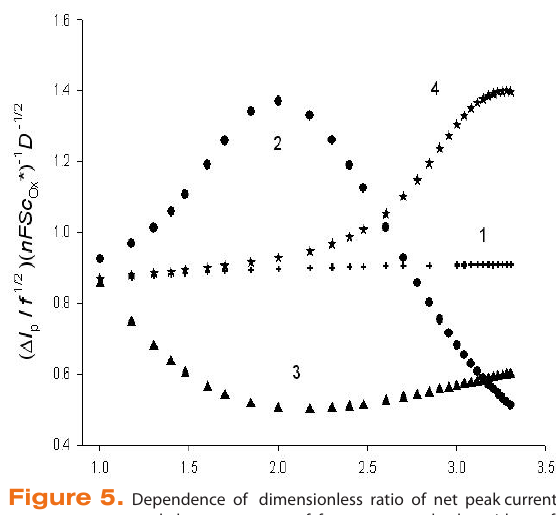
Figure 5. Dependence of dimensionless ratio of net peak current and the square-root of frequency on the logarithm of frequency. K = 0.01 cm, k / cm s -1 > 10 4 (1), = 1.6 (2), ads 0.03 (3) and 30 (4). All other parameters are as in Fig. 1.